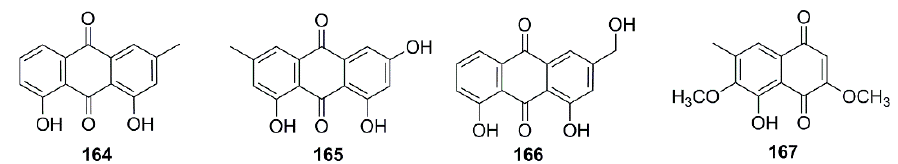
Figure 11. Chemical structures of the anthraquinones and naphthoquinones in X. strumarium.